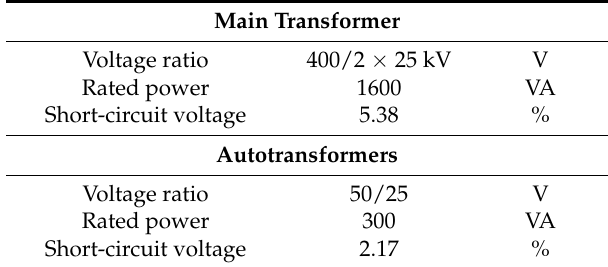
Table 4. Experimental setup transformers and autotransformers ratings.